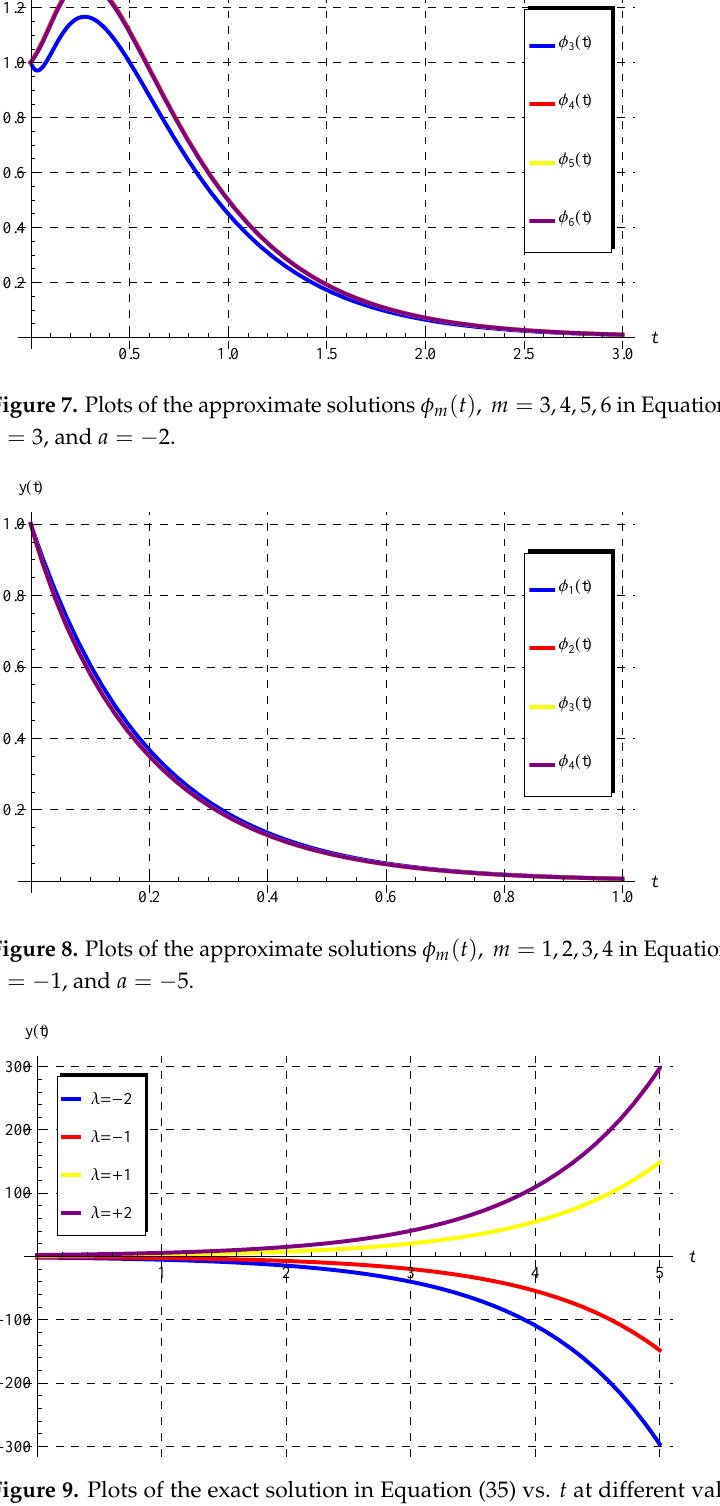
Figure 9. Plots of the exact solution in Equation (35) vs. t at different values of λ when a = 1 and b =